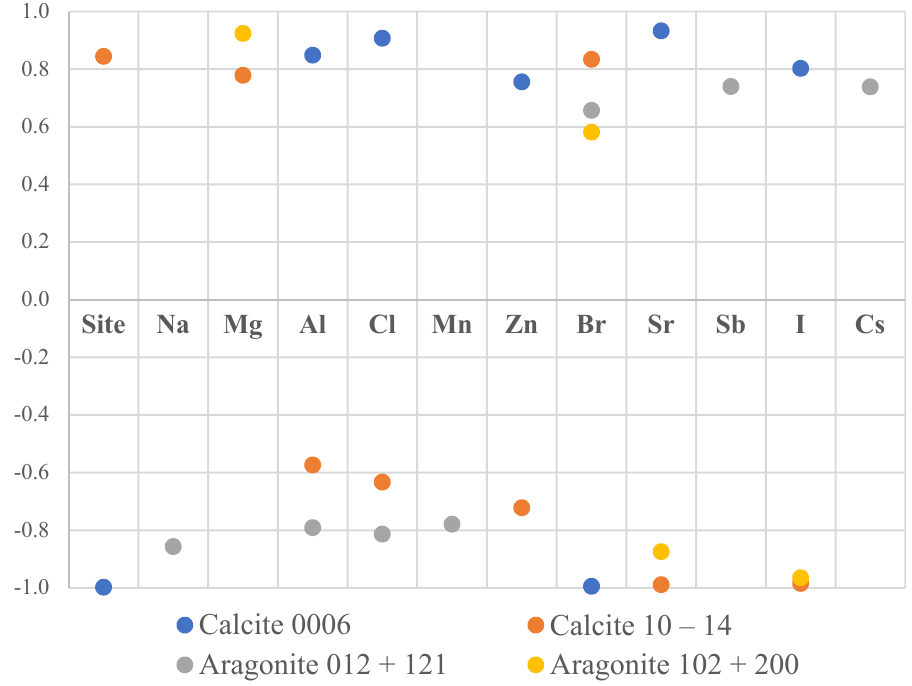
Figure 4. Significant correlations ( p < 0.05) between the maximums of the pole figures for different phases and levels of elements